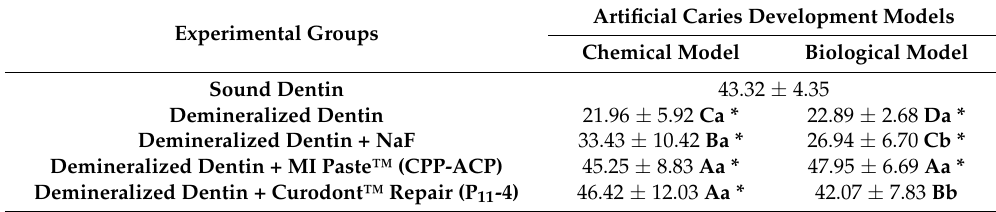
Table 2. Average and standard deviation of µ TBS of demineralized dentin considering the Artificial Caries Development Models.